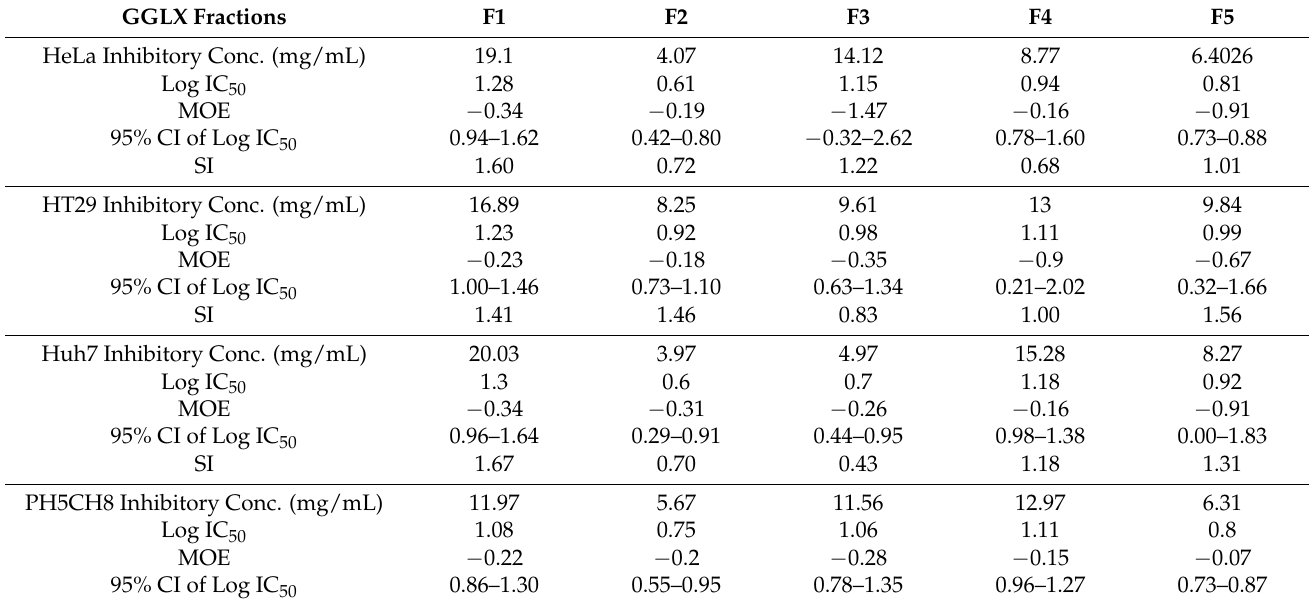
Figure 10. Dose-dependent study of GGL fractions against ( A ) HeLa, ( B ) HT29, ( C ) Huh7 and ( D ) PH5CH8 cell lines. Table 4. GGL fractions inhibitory concentrations and SI values.